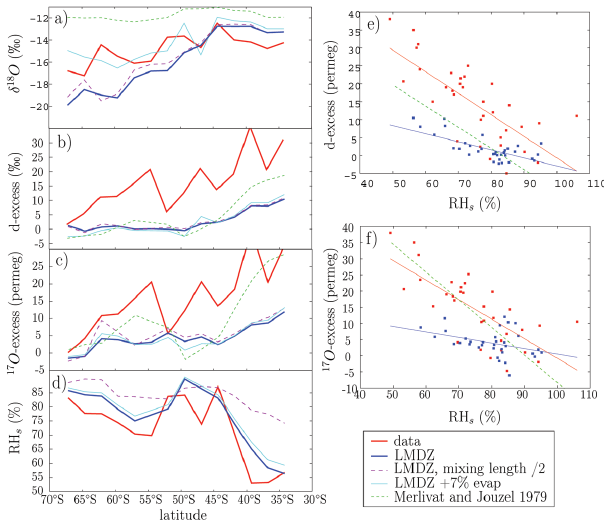
Fig. 1. δ 18 O (a) , d-excess (b) , 17 O-excess (c) and RH s (d) of sur- face water vapor measured by Uemura et al. (2008, 2010) (red) and simulated by LMDZ (blue), as a function of latitude. Results are re- gridded on the LMDZ grid and applied a smoothing Gaussian filter of 10 ◦ in latitude. D-excess (e) and 17 O-excess (f) of surface wa- ter vapor measured by Uemura et al. (2008, 2010) and simulated by LMDZ, as a function of surface relative humidity RH s . Model outputs were collocated with the measurements. Regression coeffi- cients for both simulated and observed values are indicated in Ta- ble 4. For comparison, the d-excess and 17 O-excess of surface water vapor predicted by the Merlivat and Jouzel (1979) closure approx- imation (Appendix A) is also shown in green. For clarity, we show only the regression line. Sensitivity tests using the LMDZ model (purple and cyan) are detailed in the text